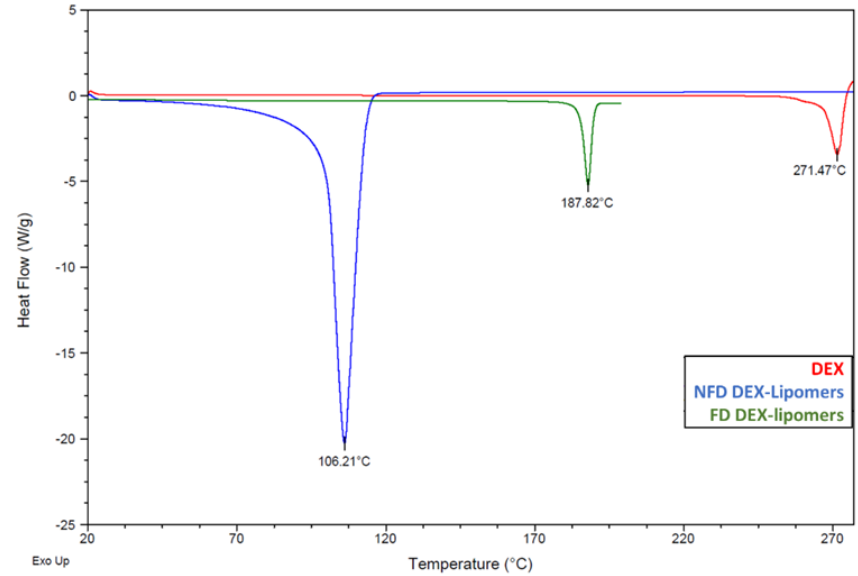
Figure 4. DSC thermogram of non-FD DEX-lipomers (blue curve), FD DEX-lipomers (green curve), and DEX (red curve).